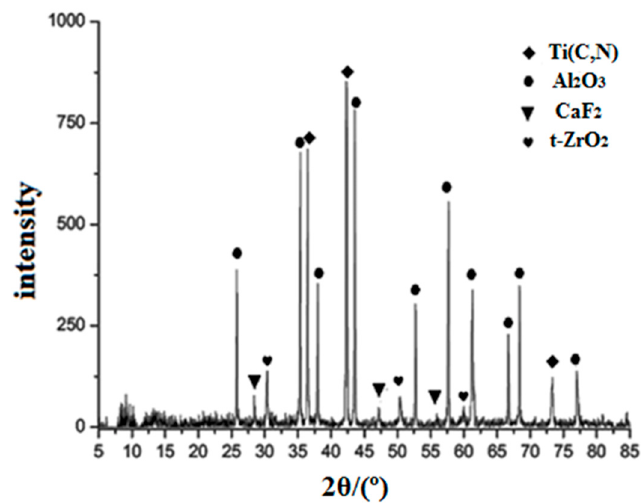
Figure 2. XRD (XRD is the abbreviation of X-Ray Diffraction) diffraction analysis of the ceramic material.